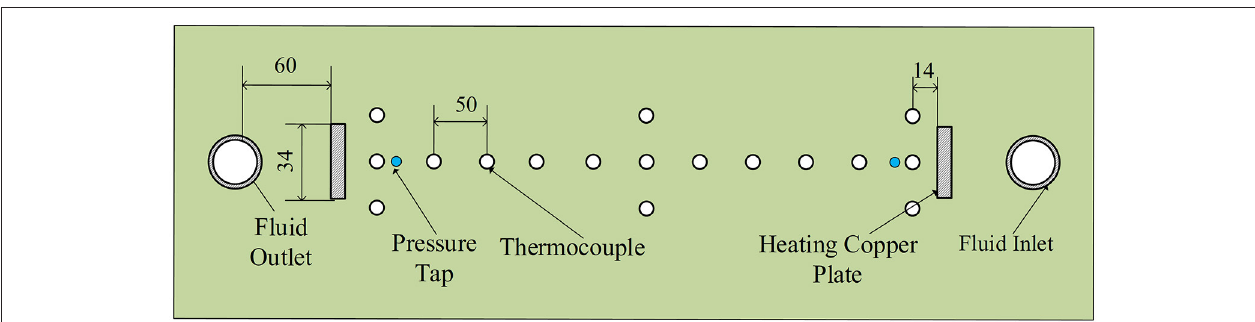
FIGURE 2 | The distribution of temperature points along the heating